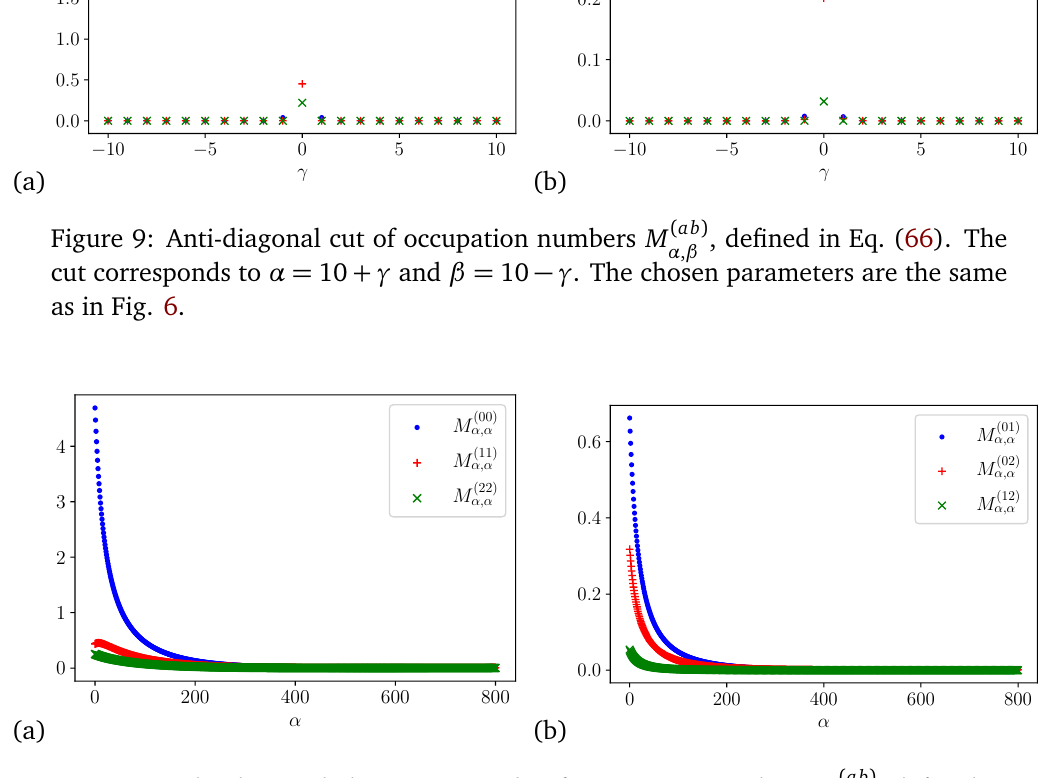
Figure 10: The diagonal elements ( α = β ) of occupation numbers M Eq. (66). The chosen parameters are the same as in Fig.